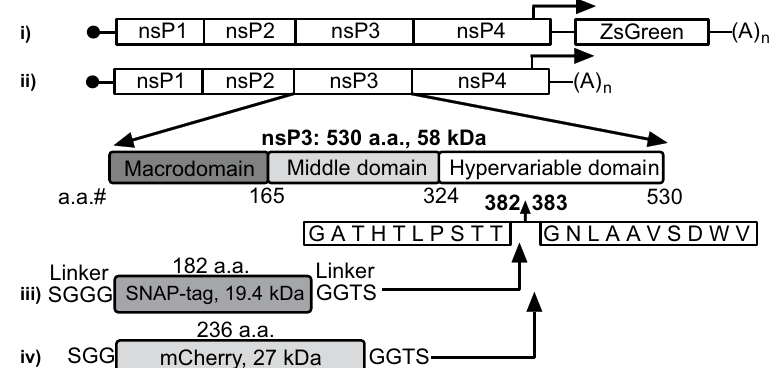
Figure 1. Inserting the SNAP polypeptide into the hypervariable domain of CHIKV nsP3. Schematic representation of replicons with a ZsGreen reporter gene ( i ) and without ( ii ). We inserted the SNAP-tag sequence between the codons that encode amino acids 382 and 383 of nsP3 (in the hypervariable domain, iii ). Flexible linker-peptides that flank the SNAP and an mCherry ( iv ) insertion are shown as well, alongside the mass of the protein insertion (in kilodaltons, kDa) and the number of amino acid residues